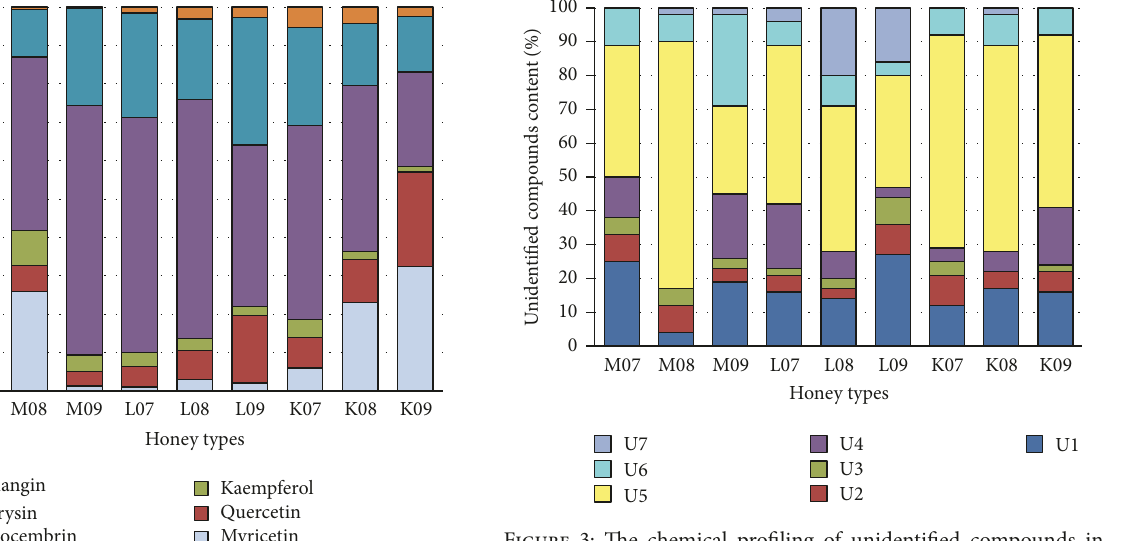
Figure 3: The chemical profiling of unidentified compounds in polyfloral honeys from northern Belgium. M07–M09 (honey sam- ples from Mortsel apiary), L07–L09 (honey samples from Lichtaart apiary), and K07–K09 (honey samples from Kasterlee